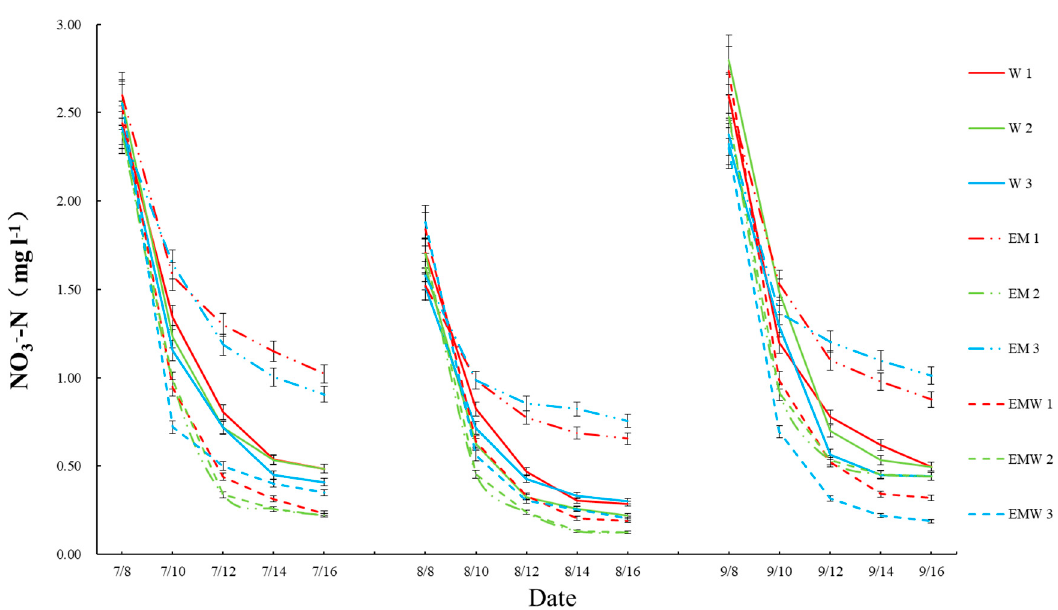
Figure 4. NO 3 − -N concentrations changes with time in wetlands.